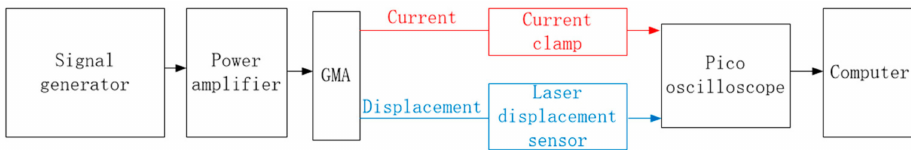
Figure 8. Schematic diagram of GMA test